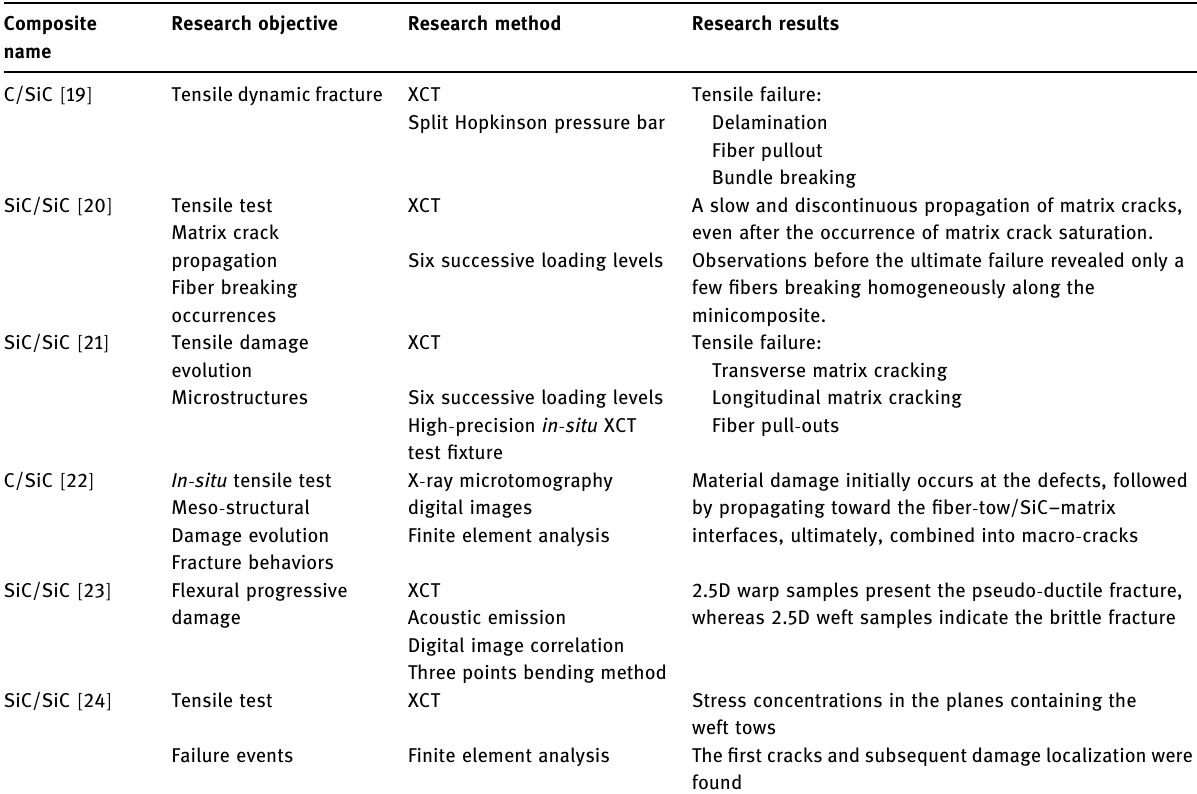
Table 1: Examples of XCT technology applied to composites Composite